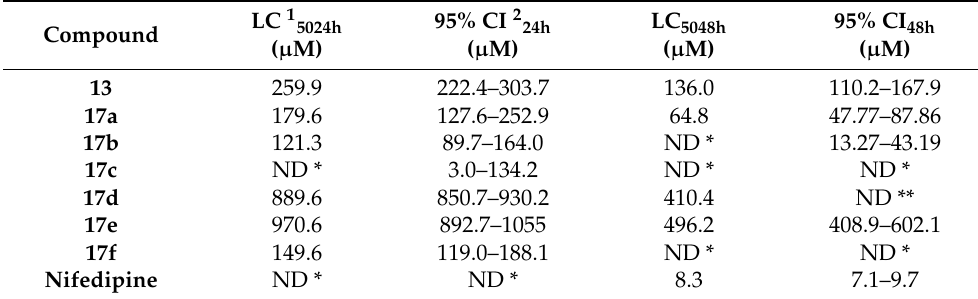
Table 2. Daphnia magna bioassay: 24 h and 48 h values, 95% confidence.